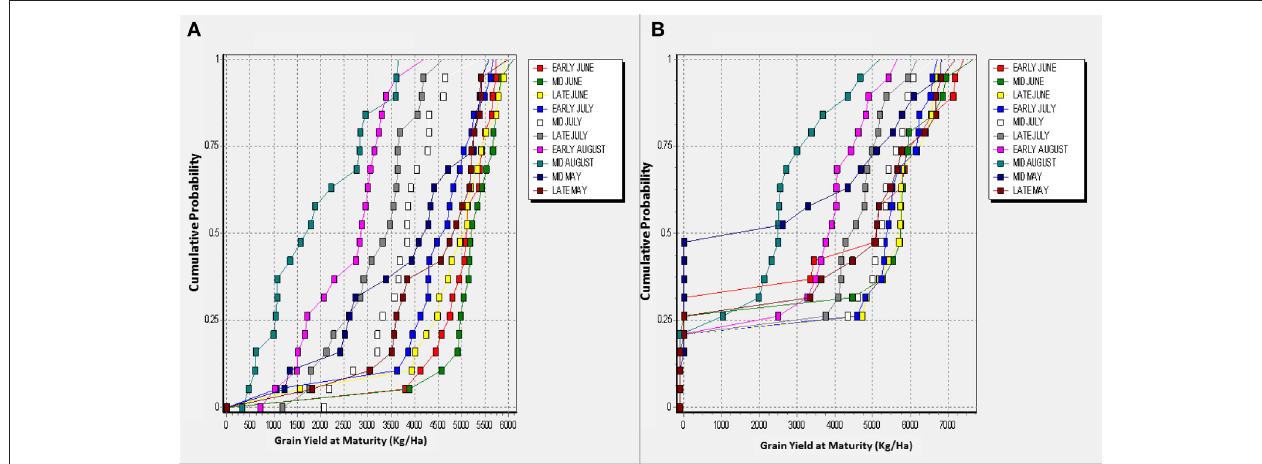
FIGURE 6 | Cumulative function plots for simulated grain yields of EVDT in Bunkure (A) and Zaria (B)